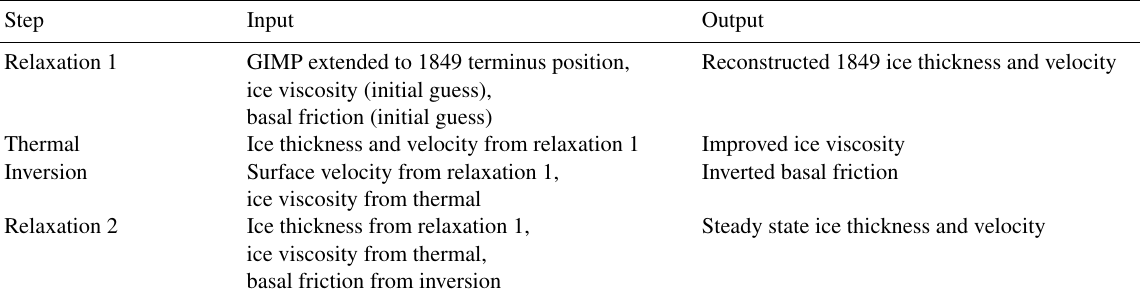
Table 2. Steps for model